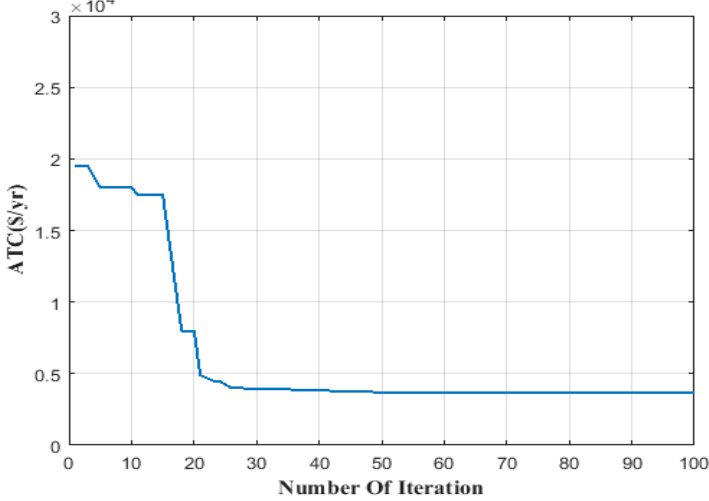
Figure 5. ATC vs Iteration number for DF.